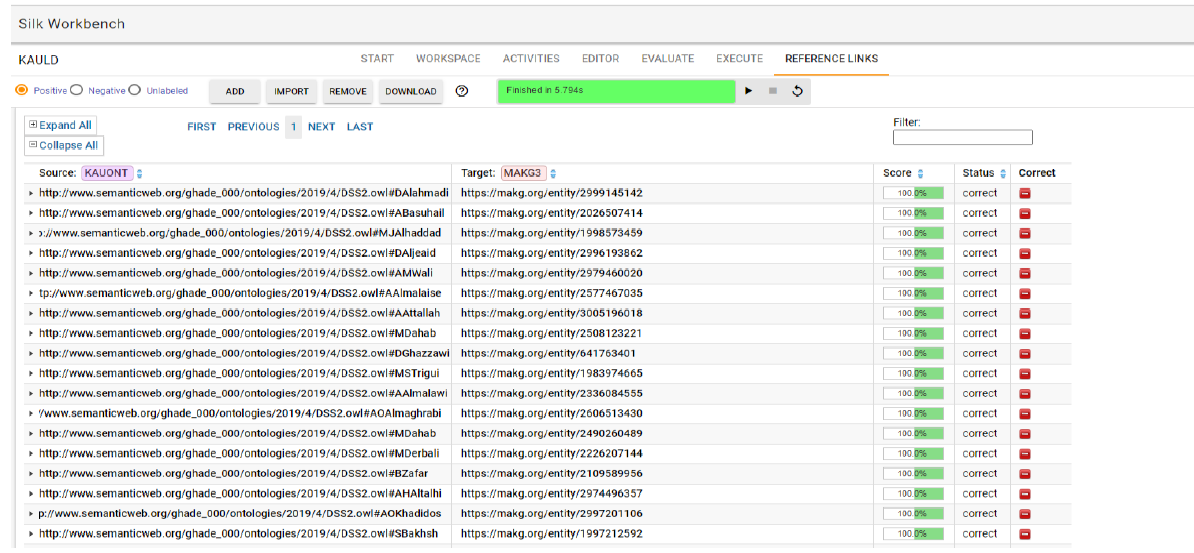
Figure 5. Generate the link using Silk Workbench editor. The results, as shown in Figures 6 and 7, include 150 links.